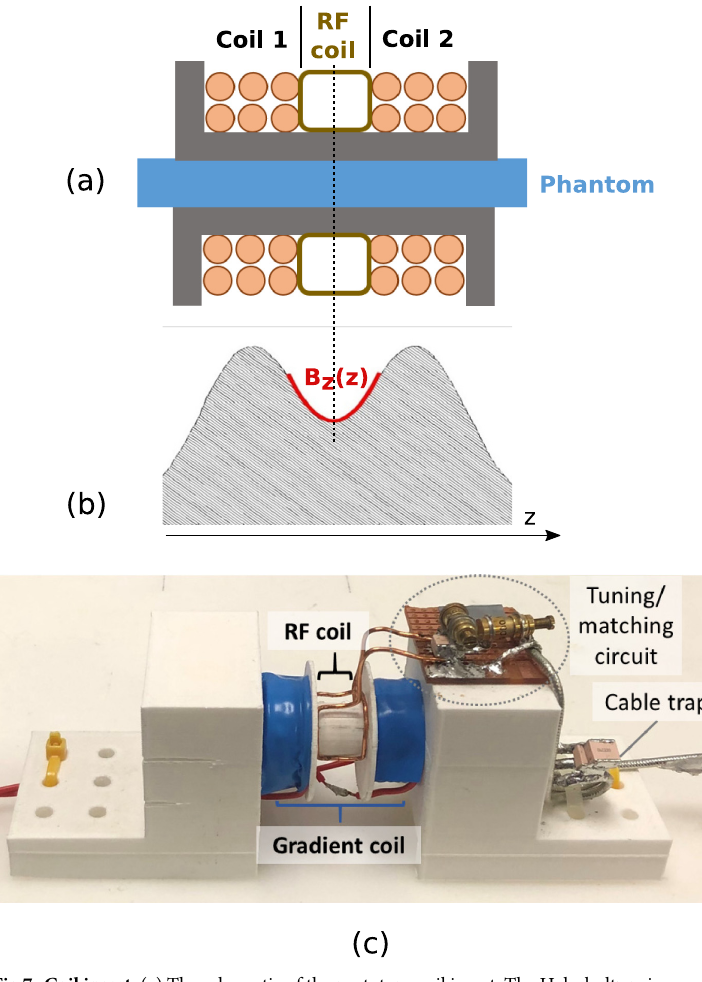
Fig 7. Coil insert. (a) The schematic of the prototype coil insert: The Helmholtz pair consists of two individual coils with a length of 11 mm and 27 windings of 28 AWG insulated copper wire each. The inner diameter of the coil is 10.5mm, the outer diameter 12.5mm. The separation between coil 1 and coil 2 is 12mm. A RF saddle coil (transmit and receive) is fitted into the separation between the Helmholtz pair. The coil insert is unshielded. (b) Gradient field B z ( z ) generated by the Helmholtz coil along the z-axis. Due to Maxwell’s equations the minimum along z is in reality a saddle point. (c) Picture of the coil insert: a 3D printed structure holds the gradient coil (wrapped in blue tape). The RF saddle coil is fitted between the Helmholz pair. The tuning/matching circuit for the RF coil is mounted on the structure as well as a cable trap (to suppress common mode currents).